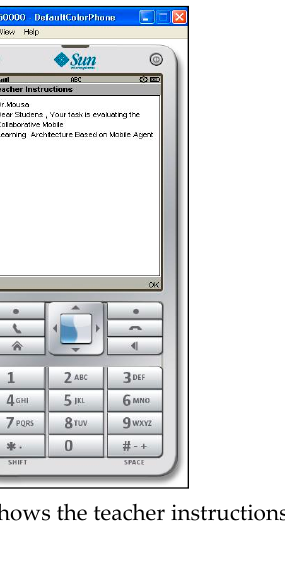
Figure 14. Mobile learning GUI—the learner agent shows social agent instructions and teacher instructions